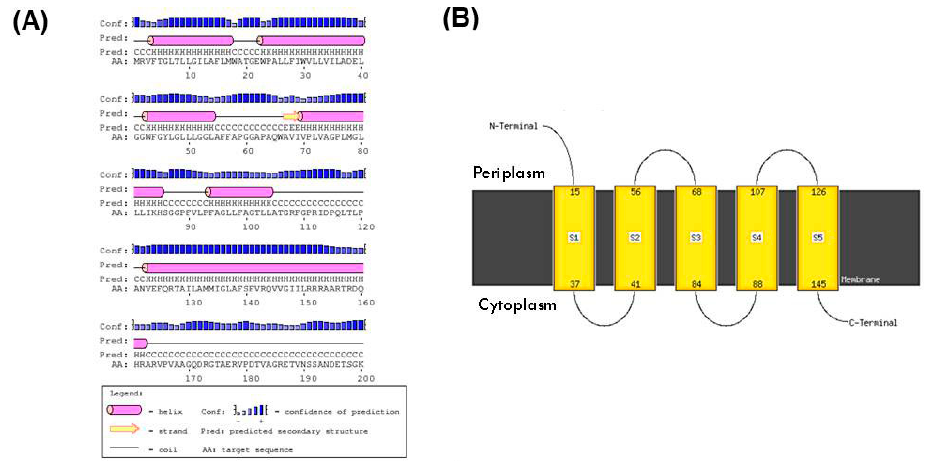
Figure 6. Secondary structure prediction ( A ) and membrane topology ( B ) of the dCSP-1 protein (Accession ID: NP_295493). Most residues in this protein are present in helix regions and it is predicted to be a cytoplasmic membrane protein with five transmembrane helices.